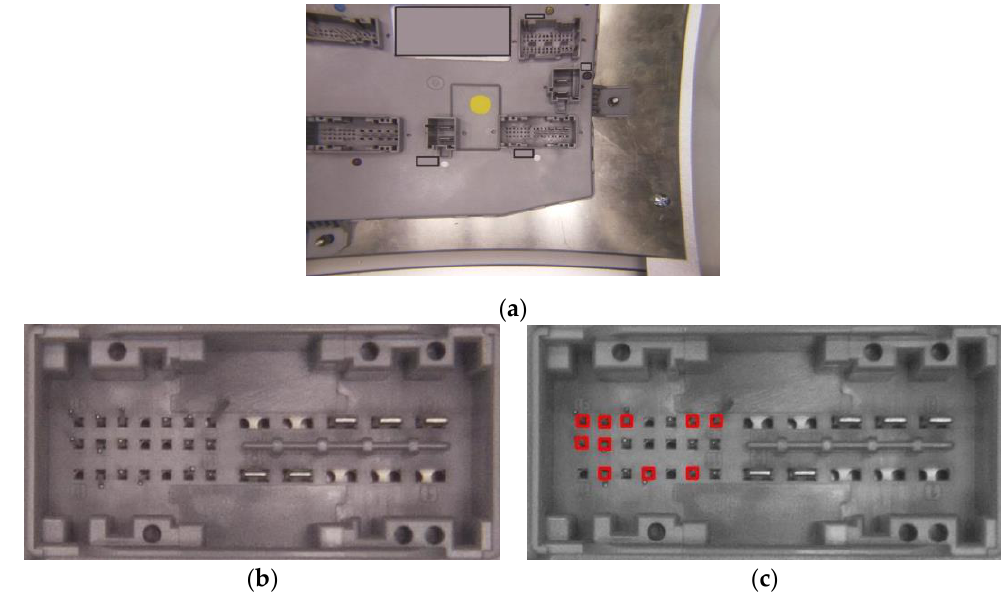
Figure 21. Results obtained with the IP-LC-FD system: ( a ) the source image taken by on slave; ( b ) the identified and extracted connector from the source image; ( c ) the faulted pins detection resulted after image processing.